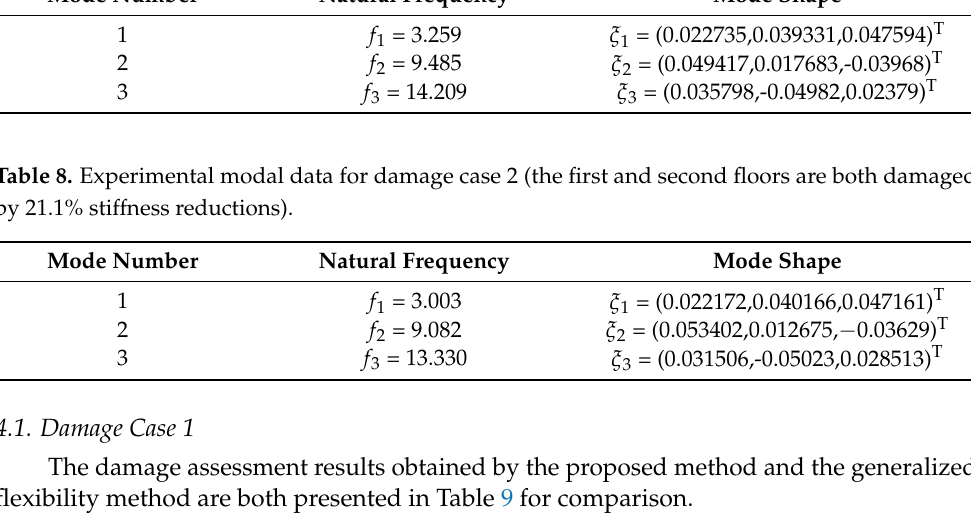
Table 8. Experimental modal data for damage case 2 (the first and second floors are both damaged by 21.1% stiffness reductions).